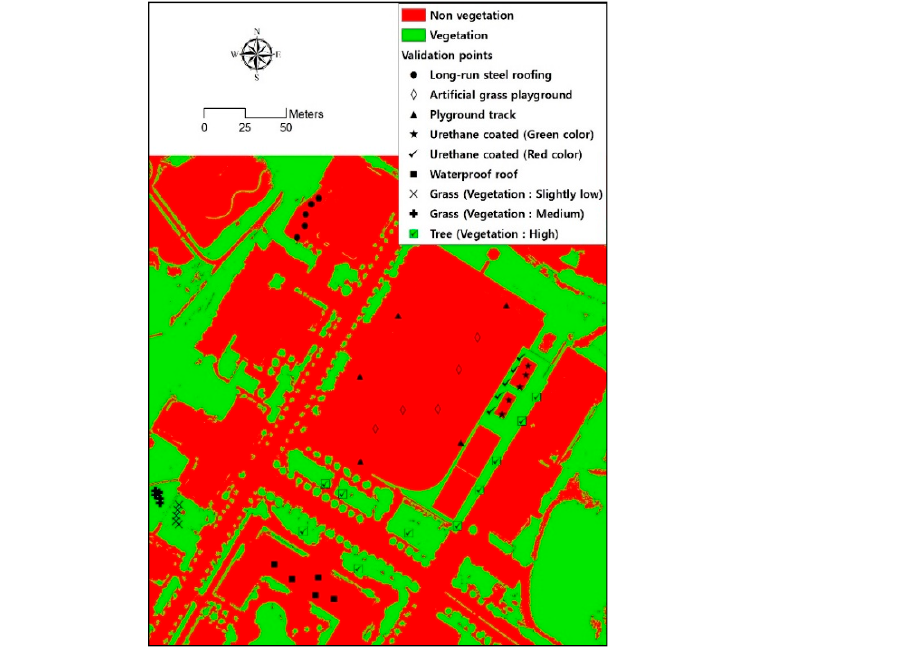
Figure 11. Vegetation map and validation points based on the squared Blue-Green NDVI index.